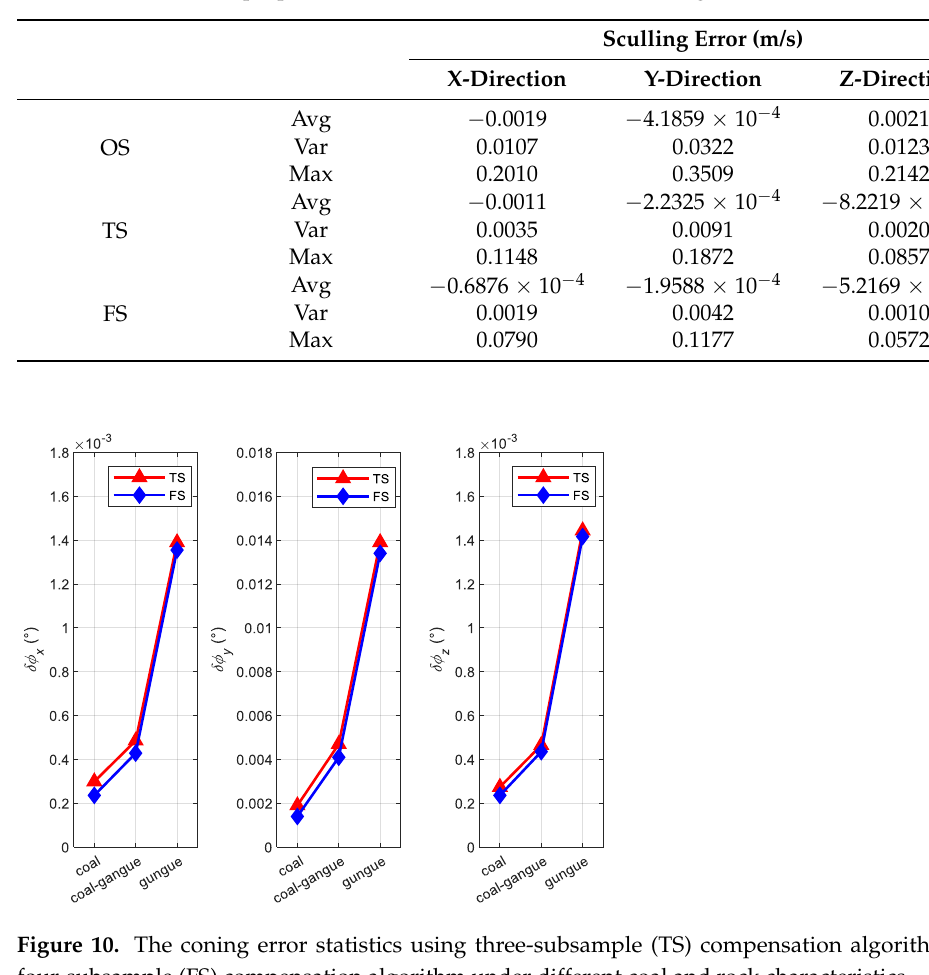
Table 3. The statistical properties of the simulation results for sculling error.